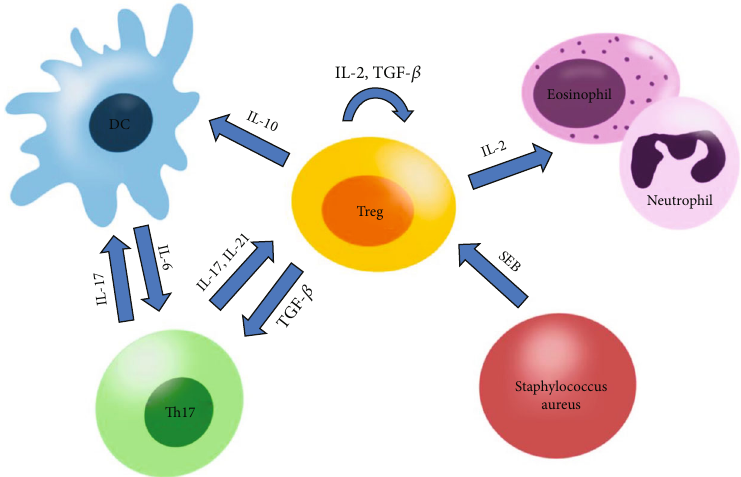
Figure 2: Interaction of di ff erent cytokines between cells in CRSwNP. In CRSwNP, Tregs secrete TGF- β to promote Th17 di ff erentiation. Th17 inhibits Treg through IL-17 and IL-21, resulting in an imbalance between Treg and Th17 cells. APCs (such as DCs) activate Th17 cells via IL-6. SEB, secreted by Staphylococcus aureus, downregulates the number of Tregs. Meanwhile, Tregs produce IL-10 to inhibit the function of DCs and activate eosinophil/neutrophils by IL-2, and Treg cells also proliferate by autocrine IL-2 and TGF- β .